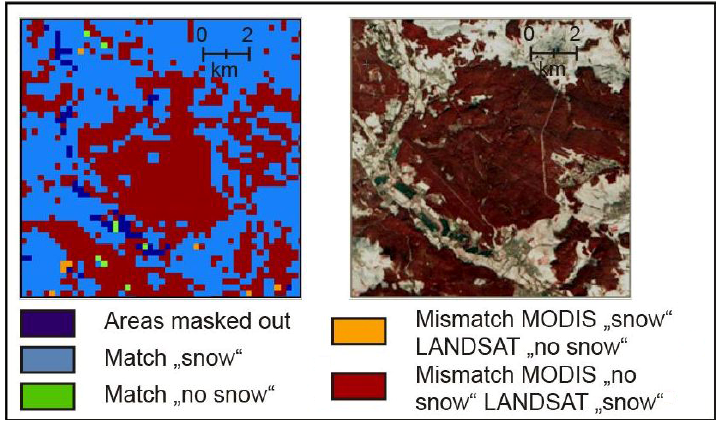
Figure 5. Largest problematic area of detecting snow in forest by the MODIS sensor through the EURAC algorithm. Left: the mismatch map between Landsat and EURAC snow cover maps (SCA) maps. Right: corresponding area in a Landsat false color image. The water bodies masked out from the comparison are also visible (dark blue pixels in left